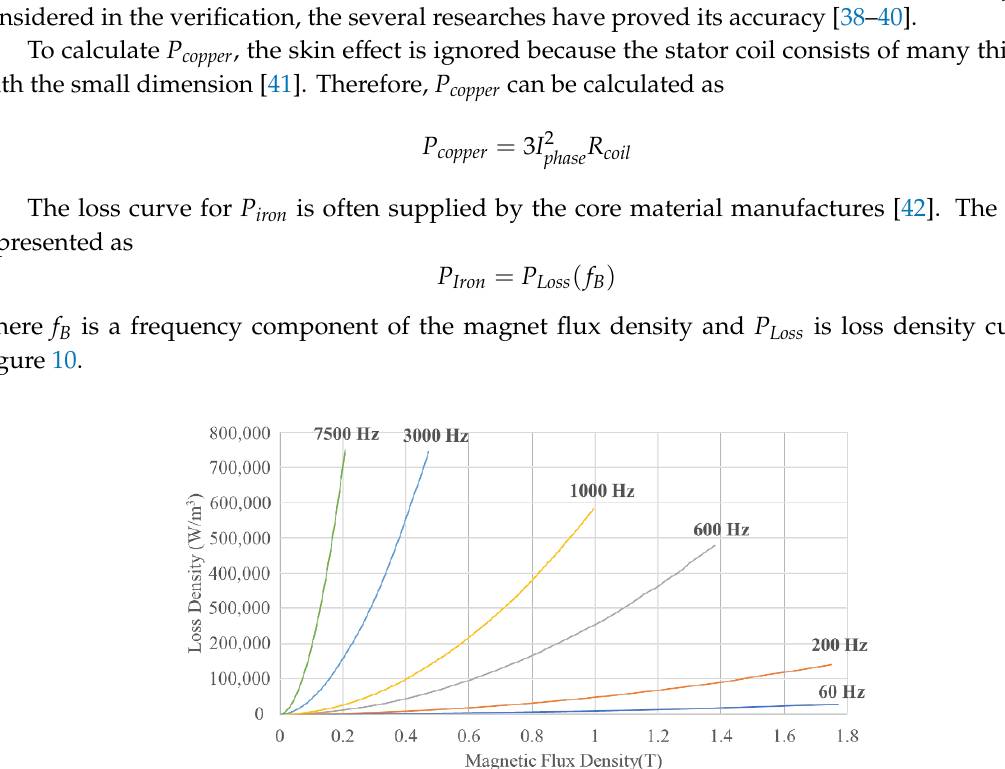
Figure 10. The loss density of stator and rotor core material (0.35 mm) depending on the magnetic flux density.